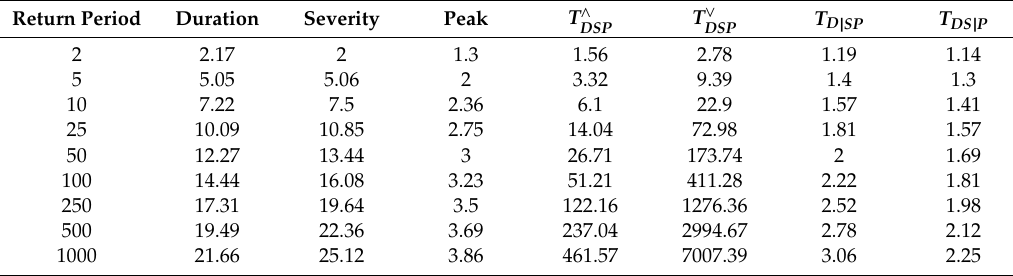
Table 7. Single and multivariate return periods of drought based on one-month TSI in the Rasht Basin. Return